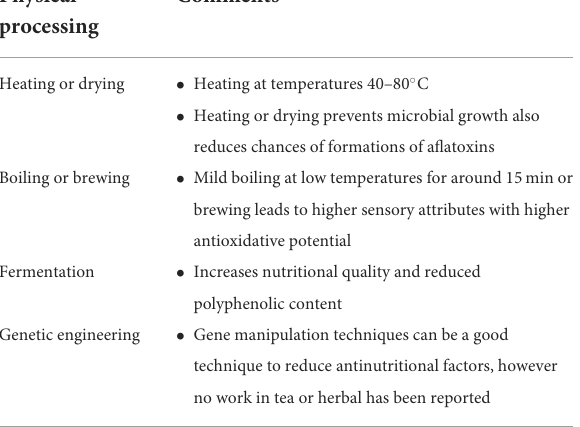
TABLE 3 Some physical processes for reducing